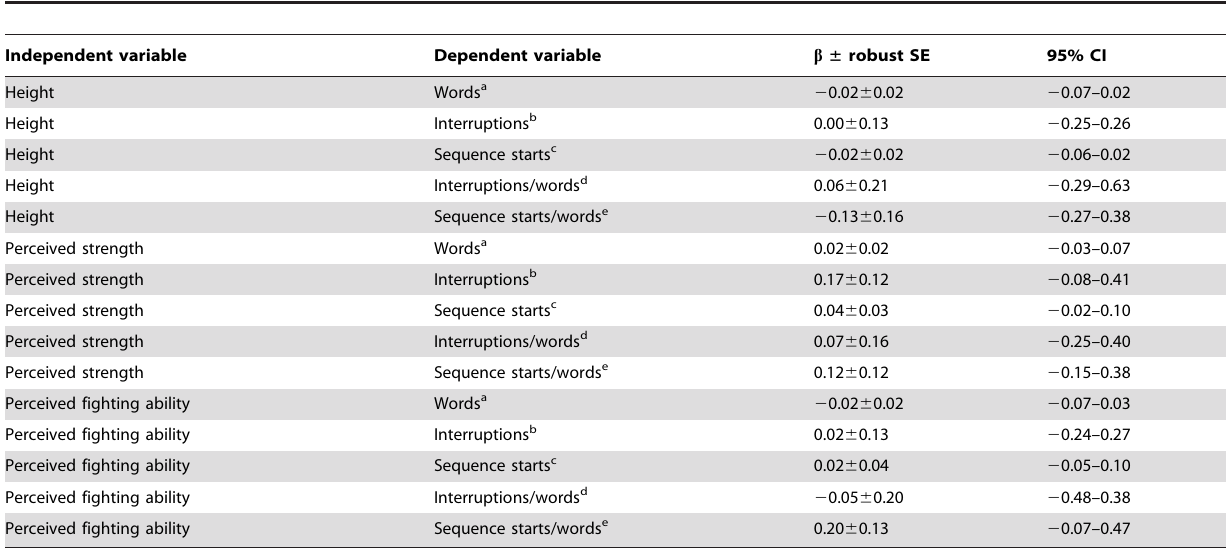
Table 1. Linear regressions of conversational dominance variables on standardized male formidability